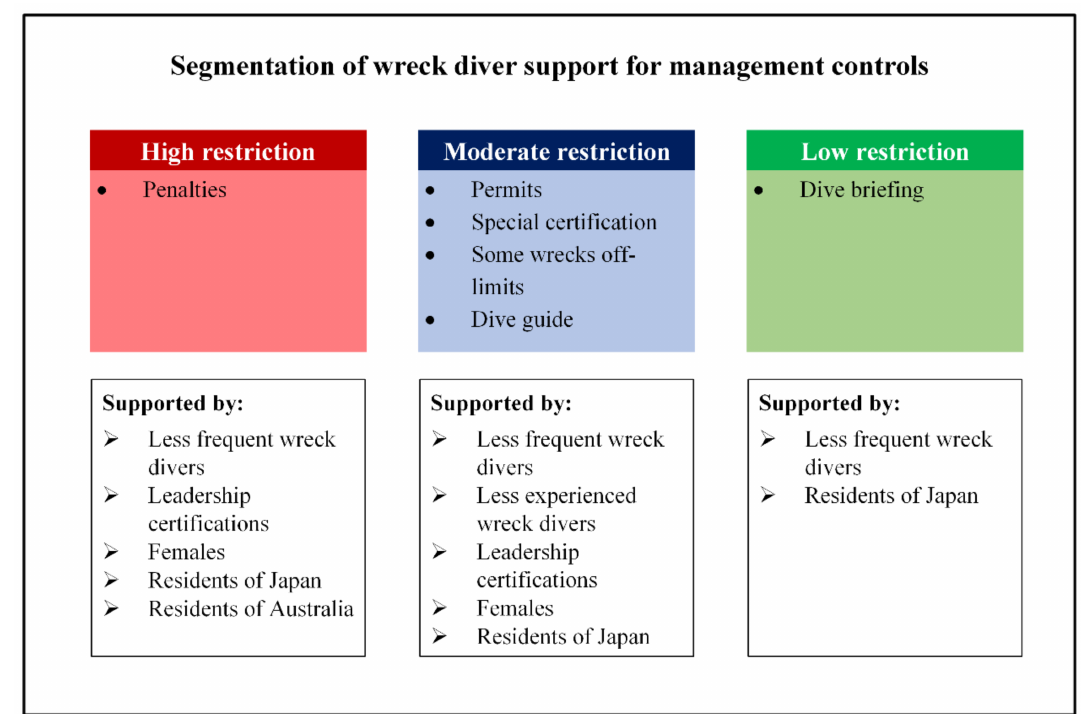
Figure 11. Segmentation of wreck diver support for management controls—adapted from [37] (p.